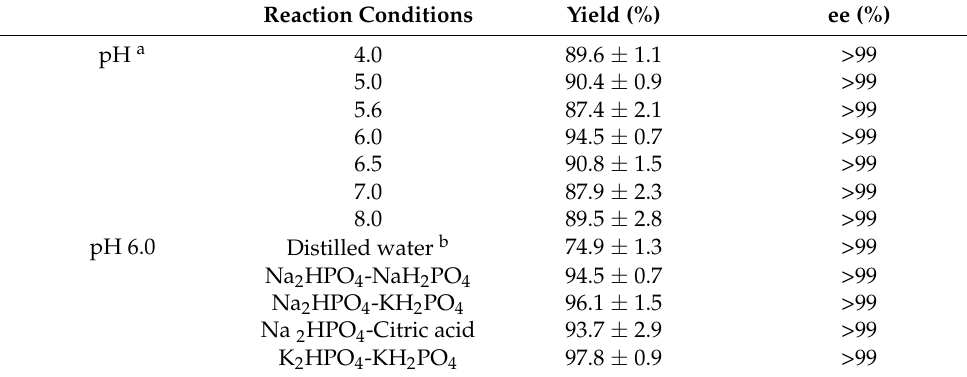
Table 1. Effect of pH on the bioreduction of 1-chloro-2-heptanone. Reaction Conditions